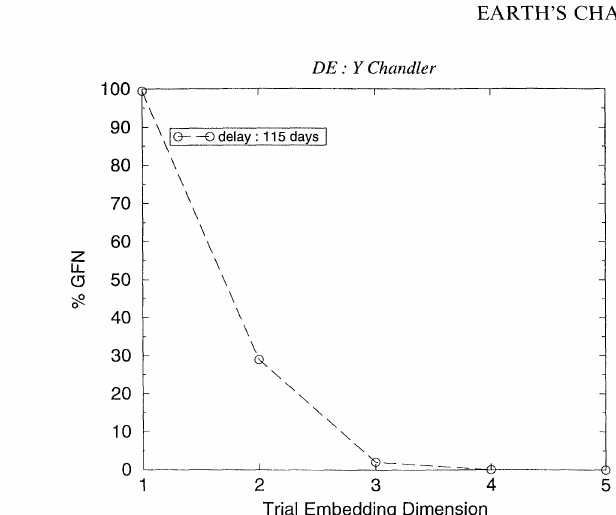
FIGURE 3 Global percentage of false neighbours as a function of the trial embedding dimension /)trial for the Y-Chandler data time series. The 0% in dimension De, 4 corresponds to the complete unfolding of the reconstructed orbit in pseudo-phase space